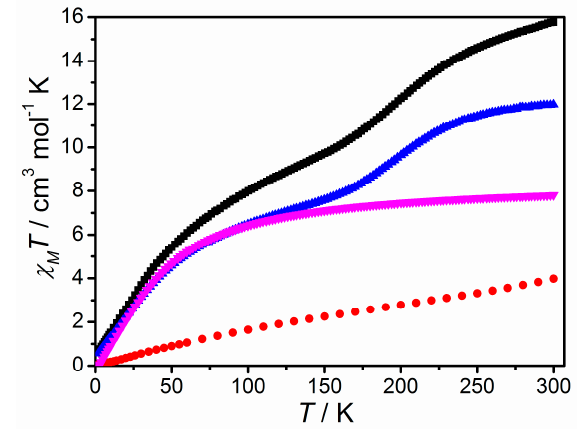
Figure 5. Plots of χ M T vs. T for 1 (black square) and [Fe II3 ( μ 3 -O)] 4+ core (red dots). The latter is the magnetic data of [{Fe II ( μ -bpt) 3 } 2 Fe II3 ( μ 3 -O)](NCS) 2 ·10H 2 O. The blue line represents the χ M T value of 1 after subtracting the contribution of the [Fe II3 ( μ 3 -O)] 4+ core. The blue curve between 35 K and 100 K is fitted by a dinuclear S = 2 model and extrapolated to 2–300 K, which represents the contribution of the dinuclear anion (pink line).